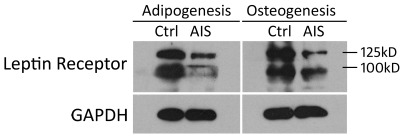
Western blot was performed to detect Leptin receptors in adipogenic and osteogenic MSCs.Two variants of Leptin receptors were present at ∼100 kD and ∼125 kD. The normal control sample (Ctrl) was from a 20-year-old girl and the AIS sample (AIS) was from a 15-year-old girl (Cobb angel = 68°). The level of leptin receptor was obviously lower in AIS sample.